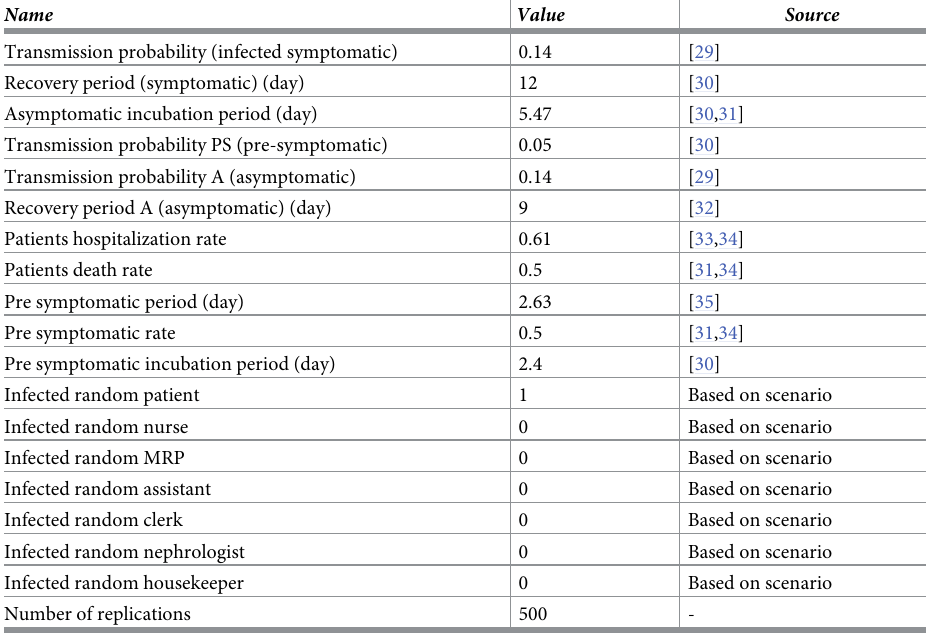
Table 5. Parameters of the agent-based disease transmission